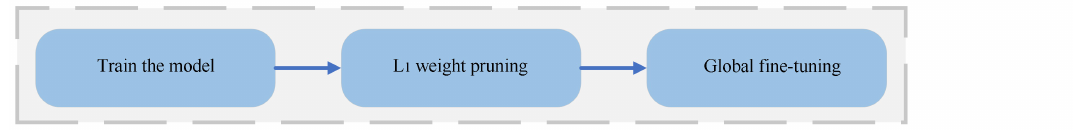
Figure 4. L 1 weight pruning